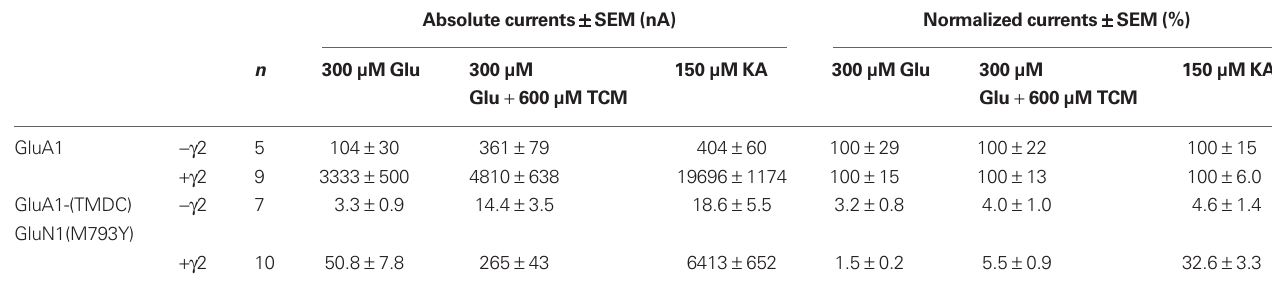
Table 2 | Absolute and normalized mean currents of gluA1 wild type and gluA1-(TMDC)gluN1(M793Y), in the absence and presence of the TARP γ 2. Absolute currents ± SeM